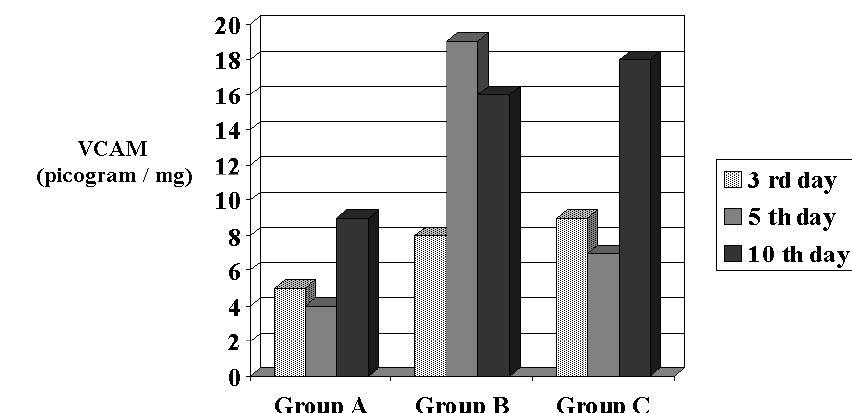
Figure 3. Levels of VCAM on the 3 rd , 5 th and 10 th days in Group A, B and C. In Group B, a statistically significant difference was found the values of the 3 rd to 5 th and 3 rd to 10 th day time intervals (p<0.05). In Group C, 3 rd -10 th and 5 th -10 th days were compared, and there was a statistically significant difference